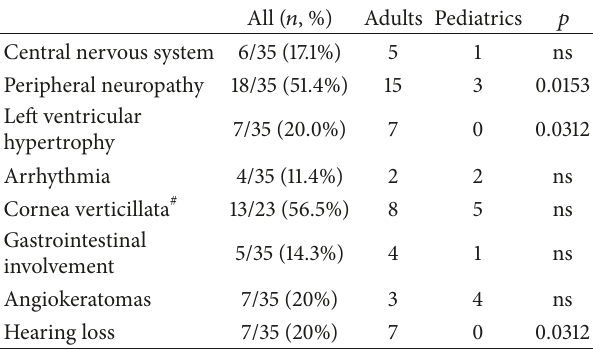
Table 2: eGFR ml/min/1.73 m 2 .